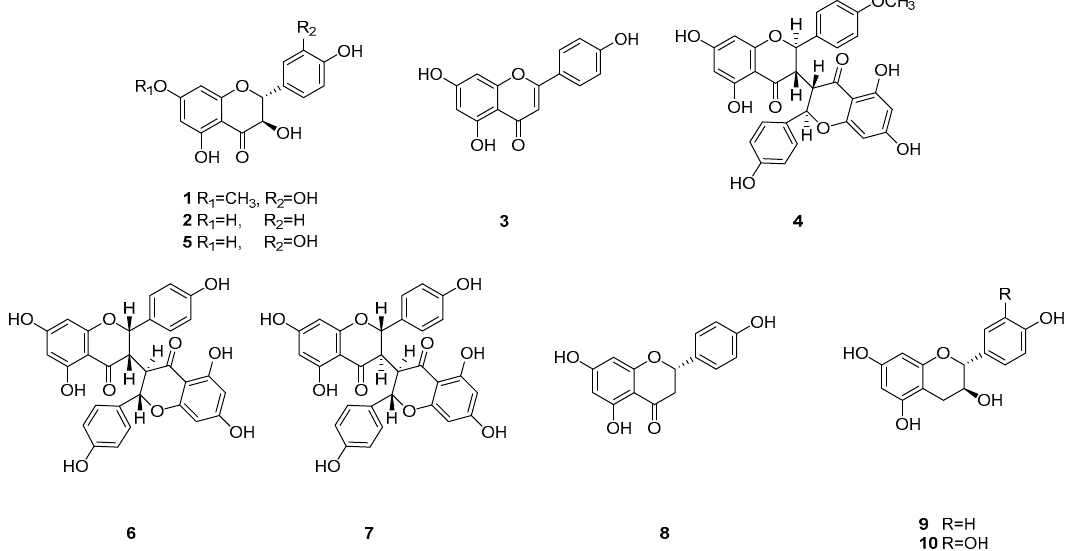
Figure 2. Structures of the ten flavonoids isolated from Wikstroemia dolichantha 95% ethanol extract.